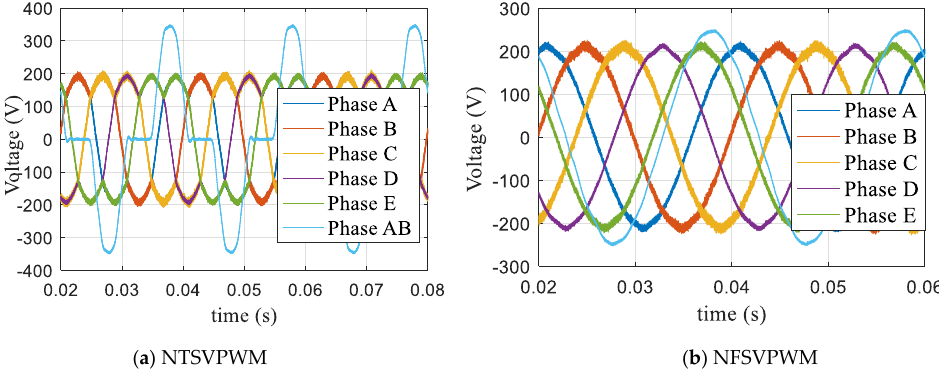
Figure 24. Voltage waveform based on traditional modulation at m = 1.0514.